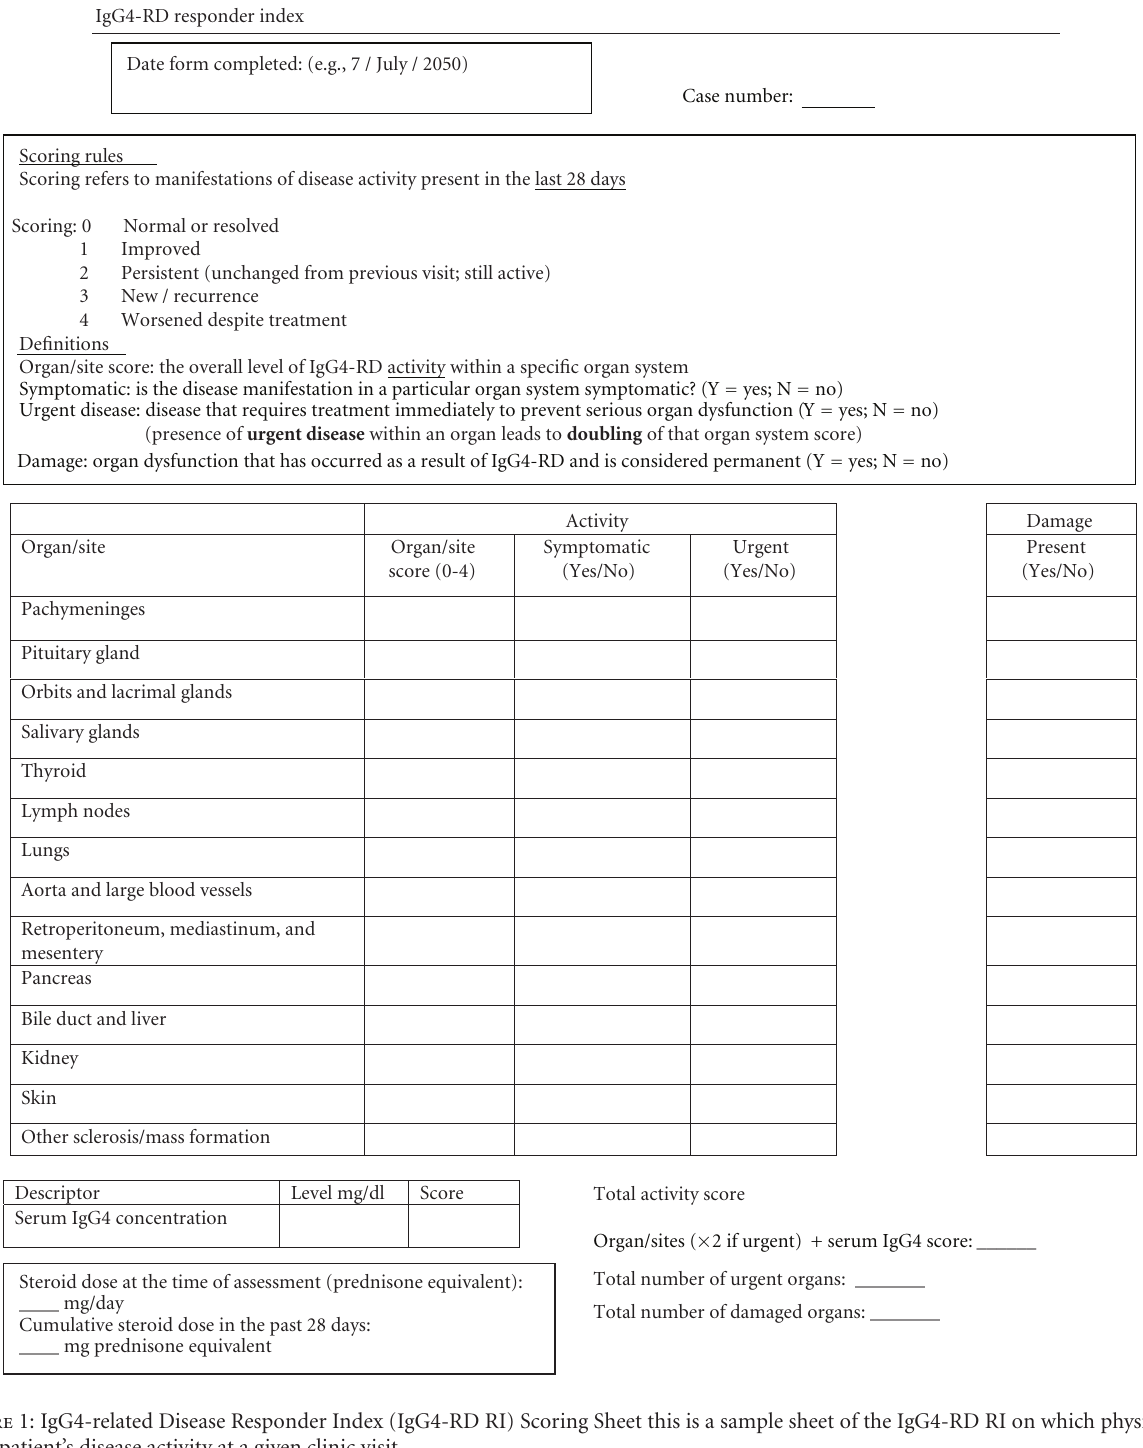
(Table 1) [3]. For ease of conceptualization, the sites of potential organ involvement are listed from head to